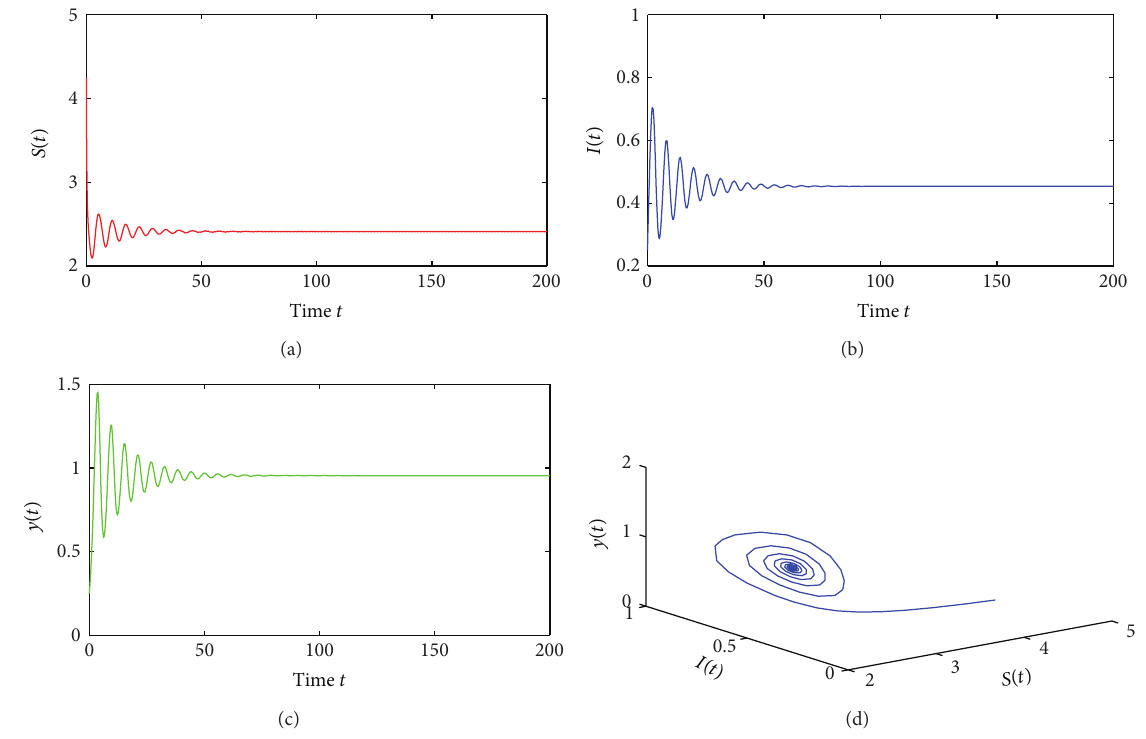
Figure 1: 𝐸 ∗ is locally asymptotically stable for 𝜏 = 1.05 < 𝜏 0 = 1.0877